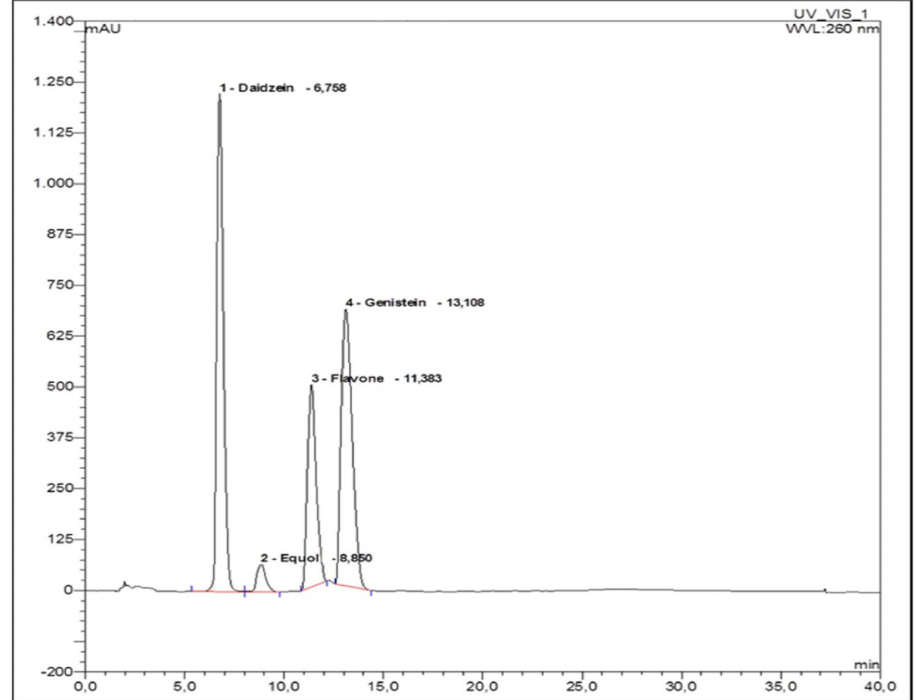
Figure 2. High performance liquid chromatographic (HPLC) chromatogram of 0.5 mM soy